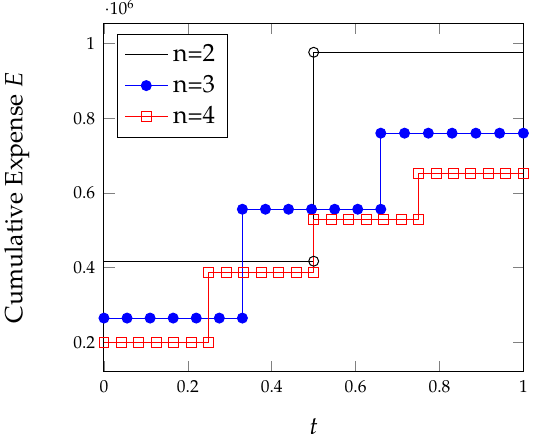
Figure 5. Optimal cumulative expense E under partial liability and GL1 model.